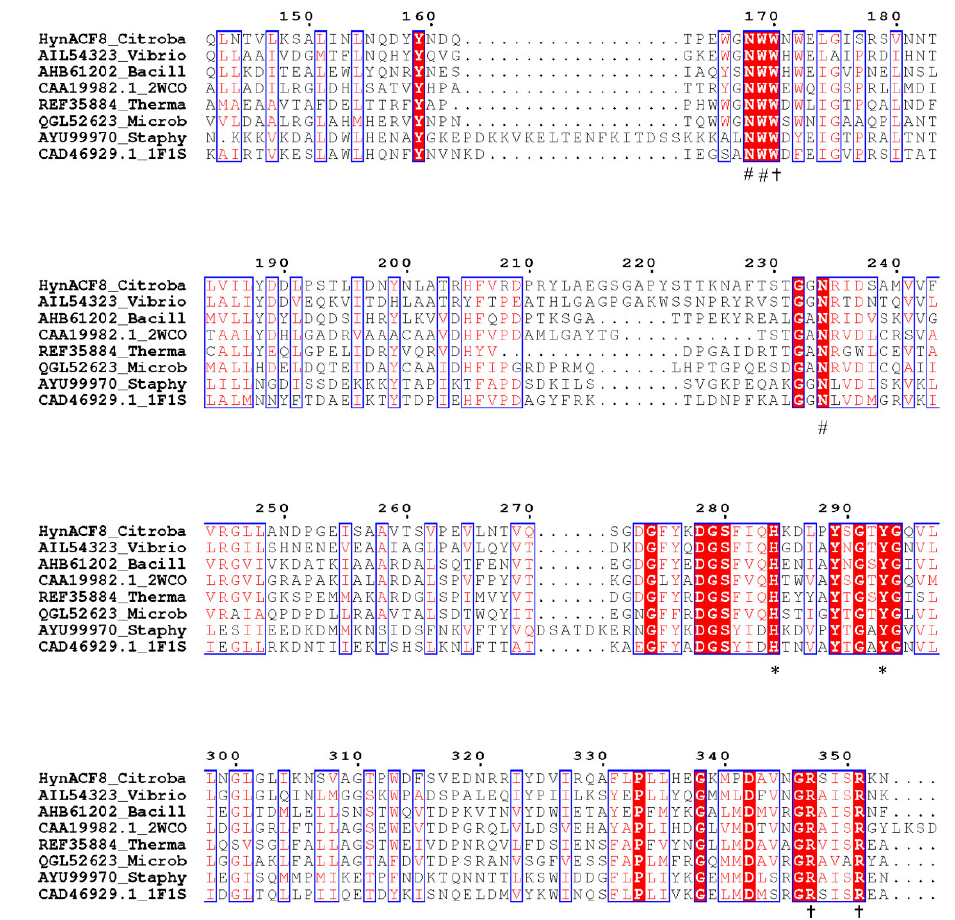
Figure 1. Partial multiple-sequence alignment of HynACF8 with PL 8 hyaluronic acid lyase. Se- quences are as follows (including accession numbers): HCLase from Vibrio sp. FC509 (AIL54323), HAase-B from Bacillus sp. A50 (AHB61202), PL8Hyal from Streptomyces coelicolor A3(2) (CAA19982, 2WCO), TcHly8C from Thermasporomyces composti DSM22891 (REF35884), HCLaseM from Microbac- terium sp. H14 (QGL52623), HylSA from Staphylococcus aureus (AYU99970), and HylB from Strepto- coccus agalactiae NEM316 (CAD46929, 1F1S). Identical and similar amino acids are shaded in boxes, respectively. Catalytic amino acid residues are marked with asterisks (*); the −1 substrate-binding subsite residues are marked with a cross (†); the +1 substrate-binding subsites are marked with a pound sign (#).